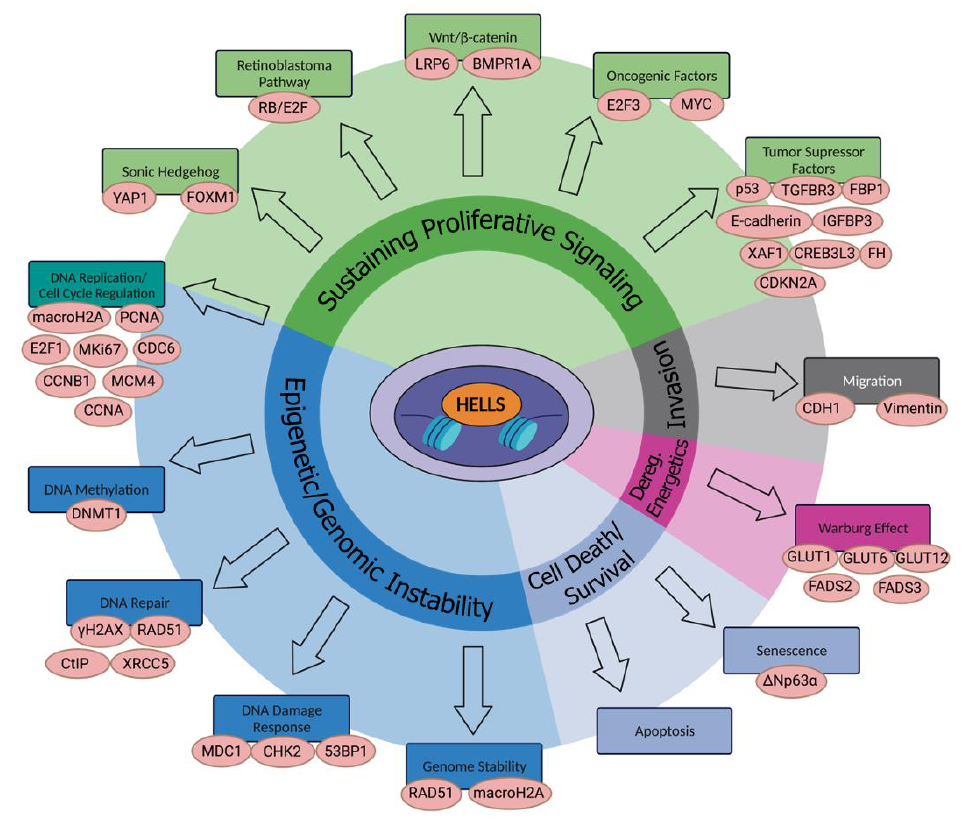
Figure 1. Association of HELLS with multiple pathways involved in cancer development, progression and influencing responses to therapy.